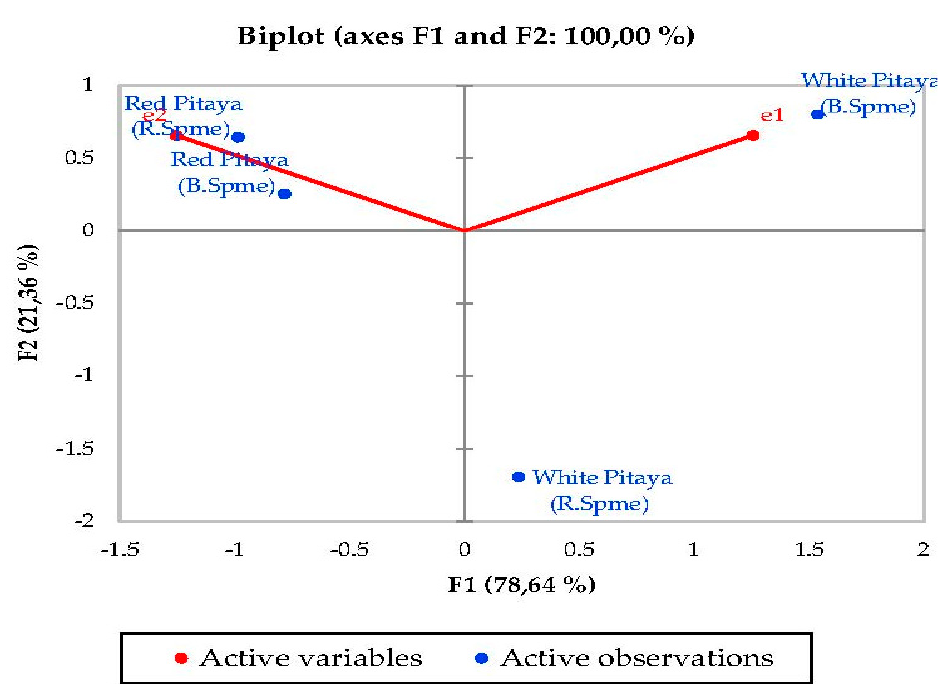
Figure 6. Biplot graph (scores and loading plots) obtained from Principal Component Analysis for esters from volatile compounds in red-white pitaya. e1: 1,2-Benzenedicarboxylic acid, diethyl ester, e2: Acetic acid, ethyl ester.